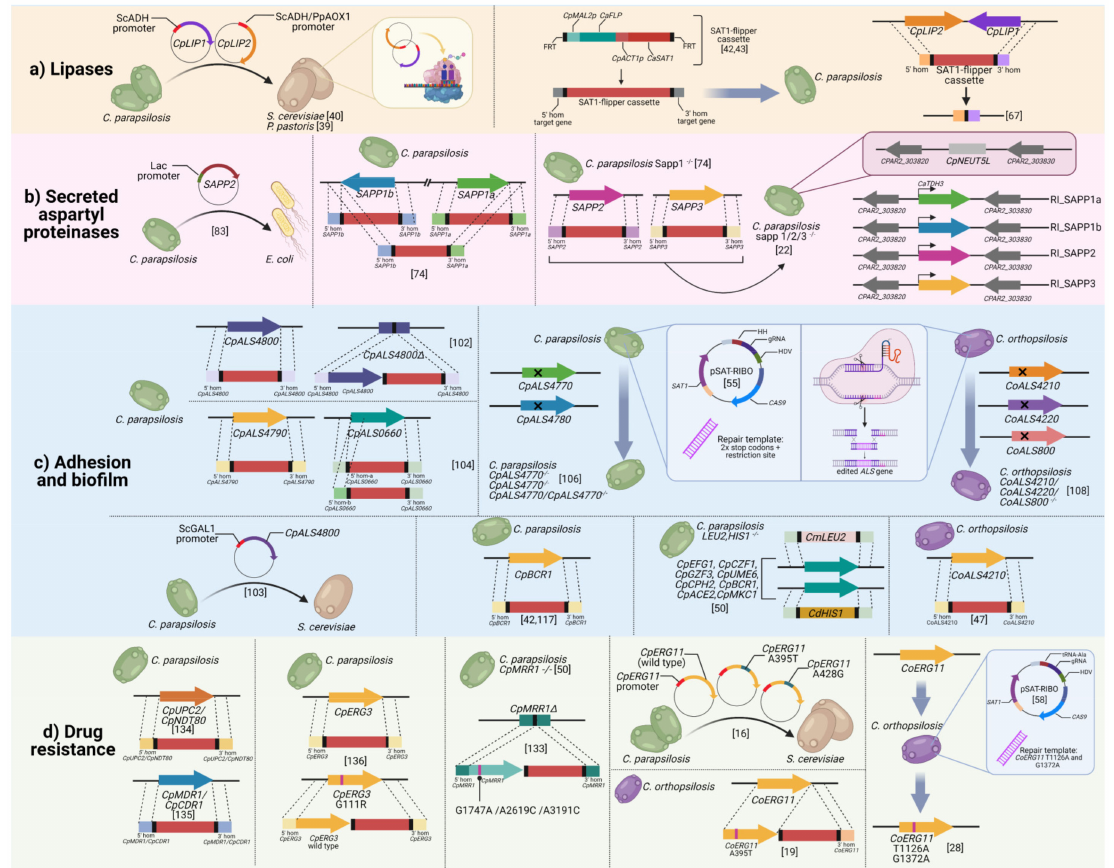
Figure 1. Overview of the genetic manipulation techniques employed to investigate the role of virulence and drug resistance genes in the C. parapsilosis species complex. The figure is divided into four panels describing the gene manipulation experiments performed to dissect the role of ( a ) lipases; ( b ) secreted aspartyl proteinases; ( c ) adhesion and biofilm; and ( d ) drug resistance genes, respectively. Each strategy illustrated in each color-coded panel is linked to its respective reference. A detailed description of each study is provided in the text of the review. Color-coding was applied to distinguish C. parapsilosis (green), C. orthopsilosis (violet), and S. cerevisiae / P. pastoris (brown). ScADH : S. cerevisiae alcohol dehydrogenase promoter; PpAOX1 P. pastoris methanol inducible promoter of the alcohol oxidase 1 gene; ScGAL1: